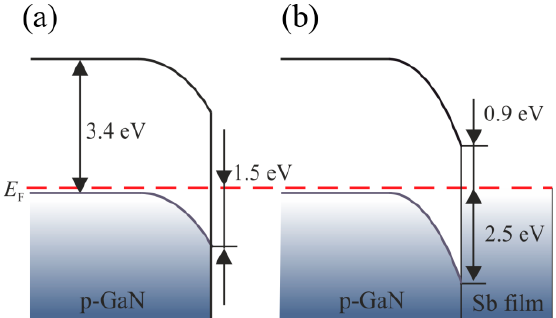
Figure 35. Band diagrams for ( a ) bare and ( b ) Sb film ‐ covered GaN(0001) surface.